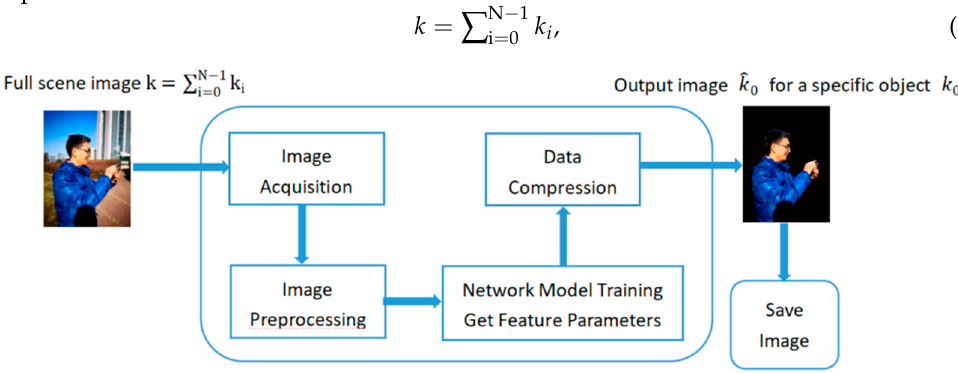
Figure 2. Schematic diagram of a specific object imaging. First of all, the full-scene image is obtained, and then the preprocessing of image screening is sent to the neural network for training, and to filter out the irrelevant background by feature information of a specific object obtained by training. Finally, the data is compressed and reconstructed to get our target image.